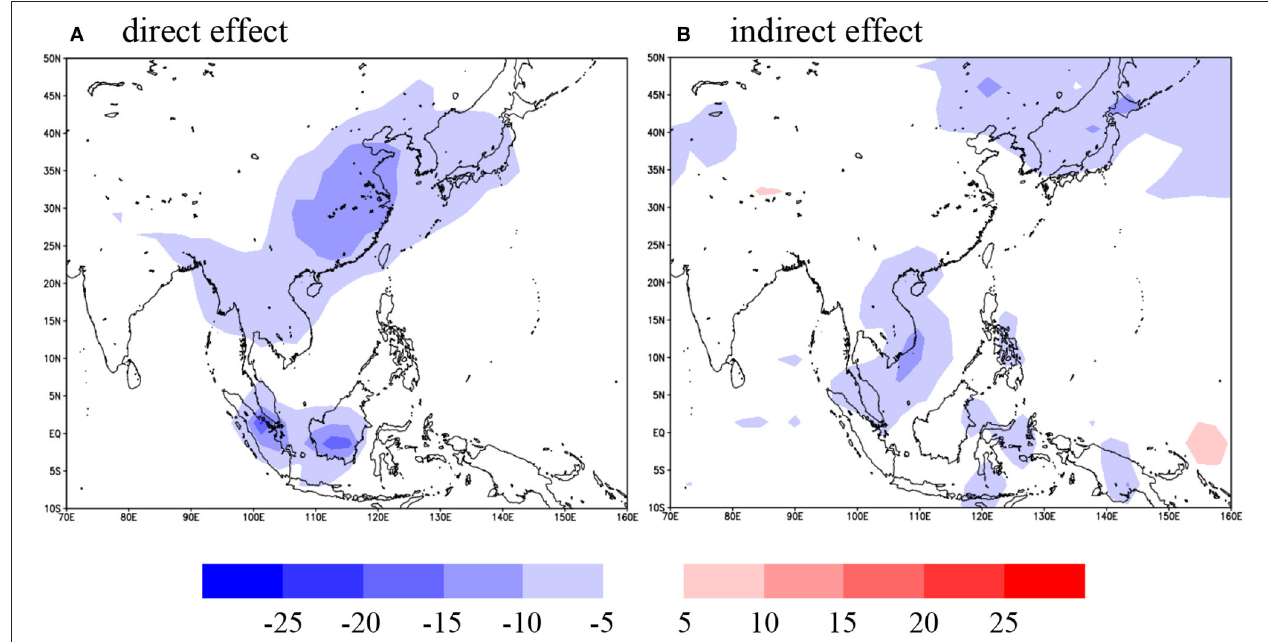
FIGURE 11 | Distribution of the 5-year mean of aerosol effects (W/m 2 ) averaged from 2001 to 2005 estimated by subtracting no aerosol forcing simulation from historical simulation. The left figure (A) shows the direct aerosol effect, which indicates a change in the shortwave radiation flux (clear sky). The right figure (B) shows the indirect aerosol effect, which indicates the shortwave radiation flux (whole sky minus clear